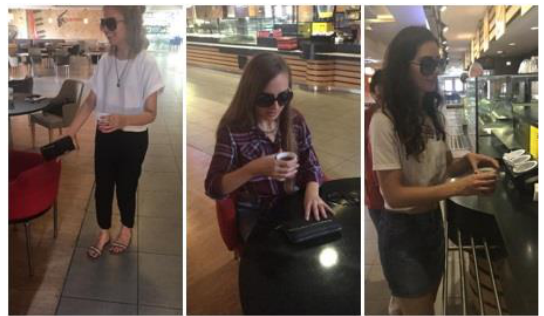
Figure 2. Simulating visually impaired people’s daily - life activities in the café environment. (Source: